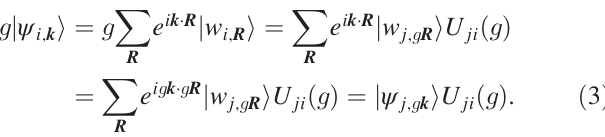
FIG. 3. (a),(b) The square of the magnitude of the Bloch states j ψ Γ from the projected method. The four panels show j w 1 j 2 at (upper left) the top layer sublattice A , (upper right) the top layer sublattice B , (lower left) the bottom layer sublattice A , and (lower right) the bottom layer sublattice B